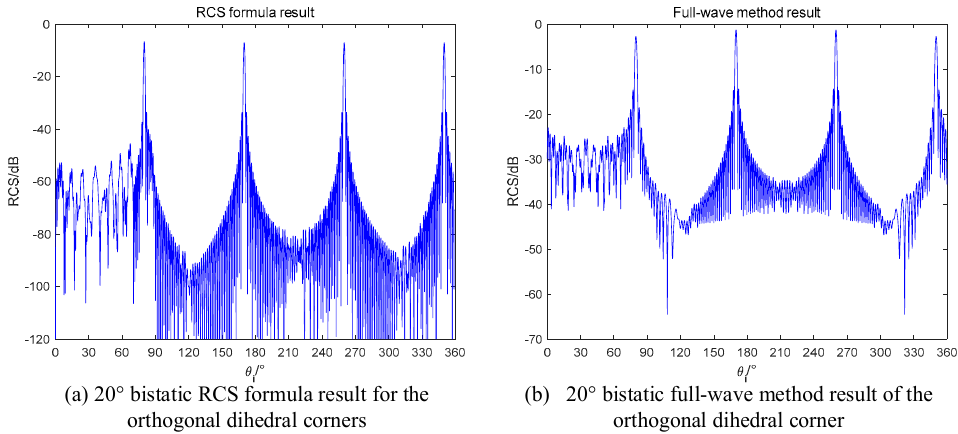
Figure 13. 20° bistatic RCS of the orthogonal dihedral ( a ) RCS formula in this paper; ( b ) Full-wave method.